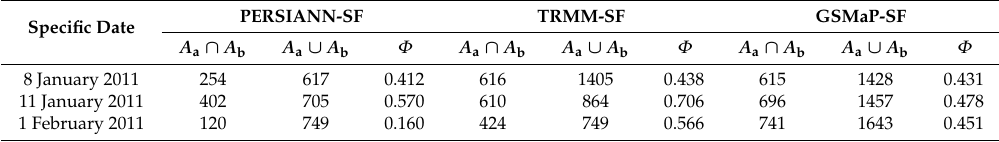
Table 8. Coincidence of inundation extent for the peak flooding times and the entire flooding periods. Values of the intersection ( A a ∩ A b ) and the union ( A a ∪ A b ) of domains of flood inundation were calculated by the SREs and Gauged-R and their rate ( Φ ) for peak flooding times in the Maha 2010–2011